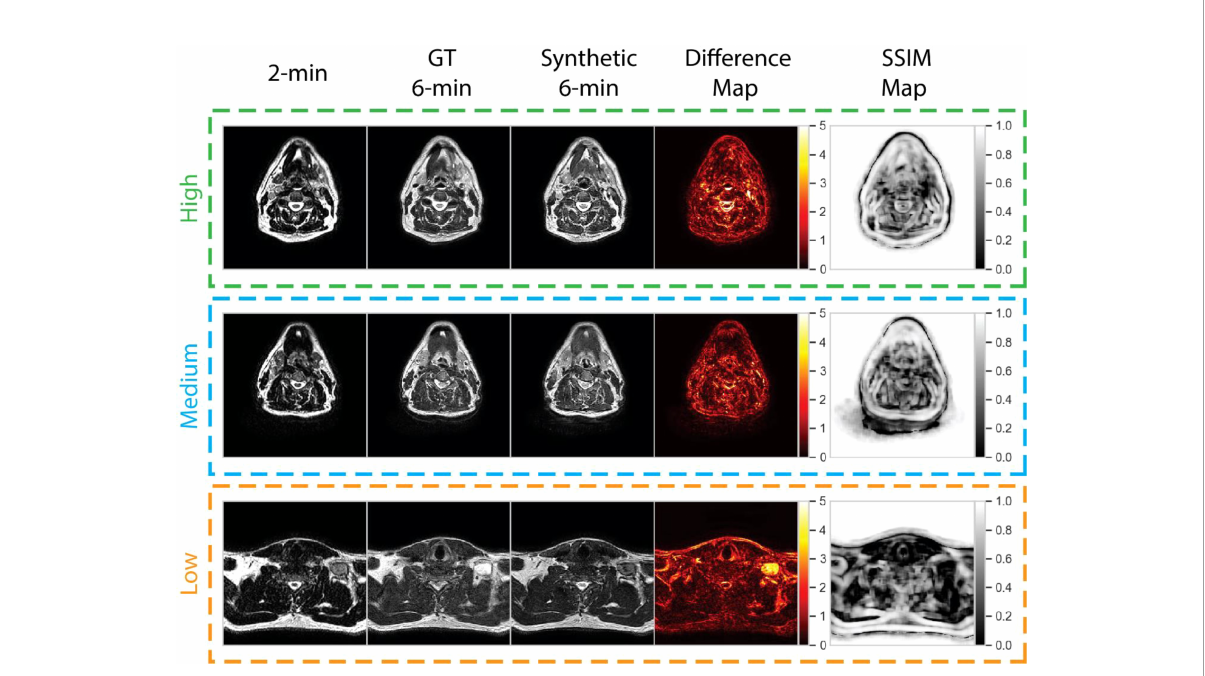
FIGURE 6 Qualitative evaluation of select cases from the test set. Cases correspond to high (green), medium (blue), and low (orange) performance relative to the median structural similarity index (SSIM) for the entire test set. Paired 2-minute scans, ground-truth 6-minute scans, synthetic 6-minute scans, absolute difference intensity maps between the ground-truth and synthetic 6-minute scans, and SSIM maps between the ground-truth and synthetic 6-minute scans are shown for each case. The high-, medium-, and low-performance cases correspond to patients with glandular (post-resection), oropharyngeal, and unknown (metastatic lymph node) primary tumors,